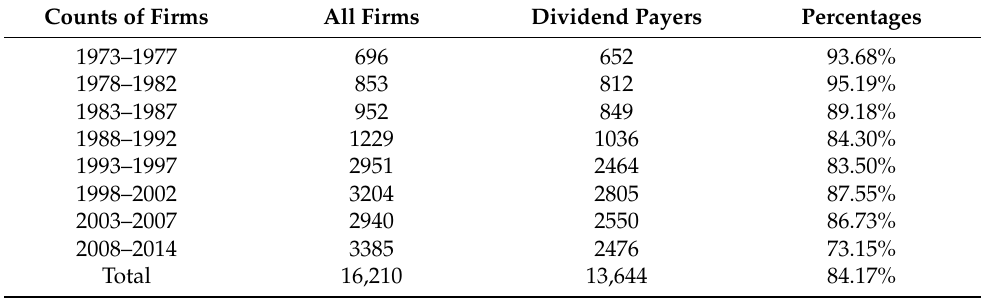
Table 1. Counts and percentages of banks in the sample counts of observations in Bank Compustat in year t. Dividend payers are firms who pay a dividend in year t. Counts of Firms All Firms Dividend Payers Percentages 1973–1977 696 652 93.68%